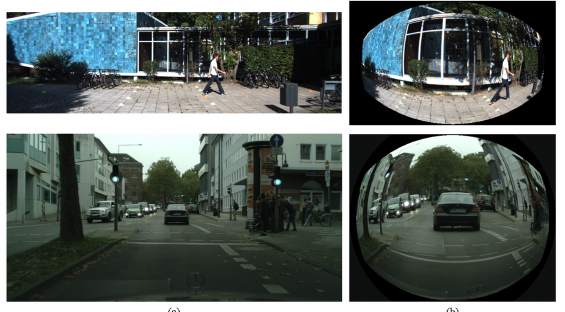
Figure 3. ( a ) Original image. ( b ) Synthetic fisheye images from KITTI ( top ) and CityScape ( bottom